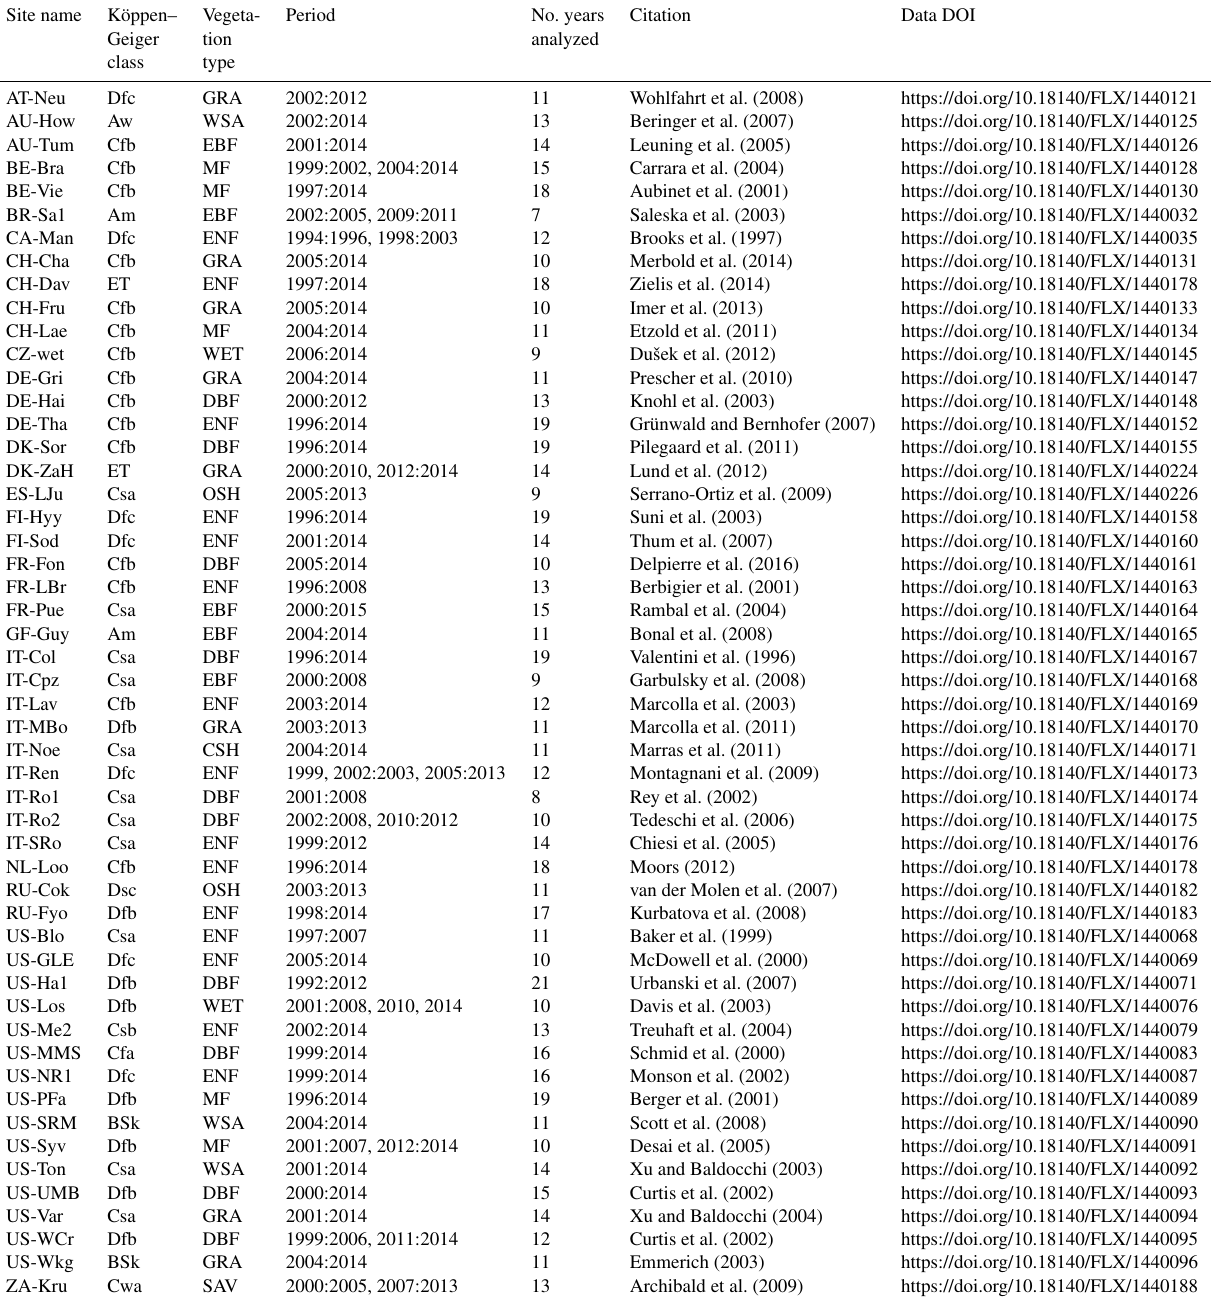
Table A1. FLUXNET sites used in our study. We report the name of the sites, the time period used for the analysis, and the climate class of each site following Köppen–Geiger classification: tropical monsoon climate (Am), tropical savanna climate (Aw), cold semiarid climate (BSk), humid subtropical climate (Cfa), oceanic climate (Cfb), hot summer Mediterranean climate (Csa), warm summer Mediterranean climate (Csb), humid subtropical climate (Cwa), humid continental climate (Dfb), subarctic climate (Dfc, Dsc), and tundra climate (ET). We also report the vegetation type of the sites: closed shrubland (CSH), deciduous broadleaf forest (DBF), evergreen broadleaf forest (EBF), evergreen needleleaf forest (ENF), grassland (GRA), mixed forest (MF), open shrubland (OSH), savanna (SAV), permanent wetland (WET), and woody savanna